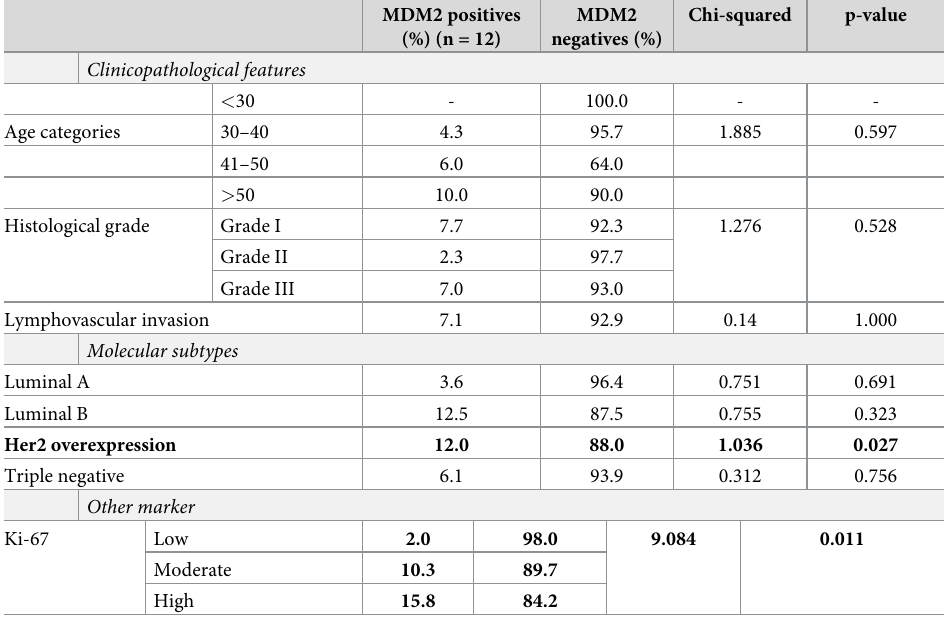
Table 5. Association of MDM2 with clinicopathological features, molecular subtypes and other